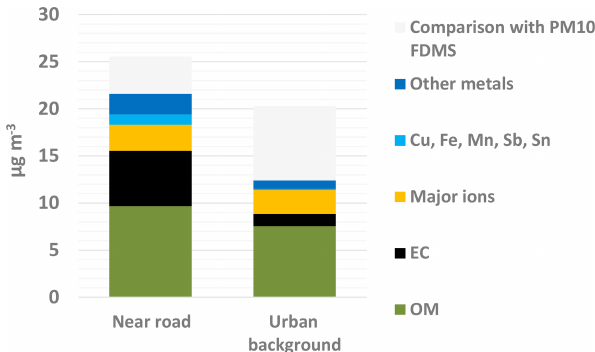
Figure 2. Median concentrations measured at the roadside site (Echirolles) and urban background site (Les Frênes) as well as comparison with respective median TEOM-FDMS PM 10 concen- trations. Organic matter (OM) is computed using the factor 1.8 es- timated for Grenoble city (Favez et al.,